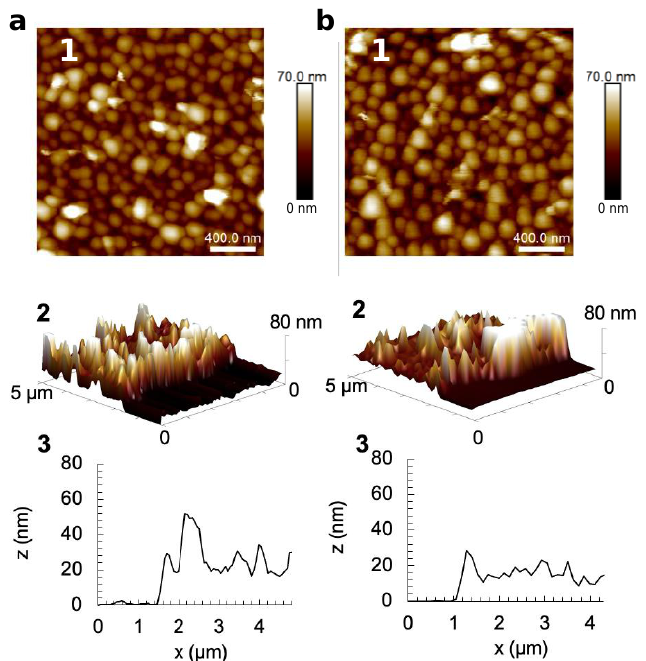
Figure 2. AFM characterization, in contact mode and the liquid state, of ( a ) (COL/TA) 3 and ( b ) (COL/TA) 3 -COL films: (1) surface topography, (2) AFM 3D images, and (3) cross-section profiles of scratched films in their respective pH buffer.